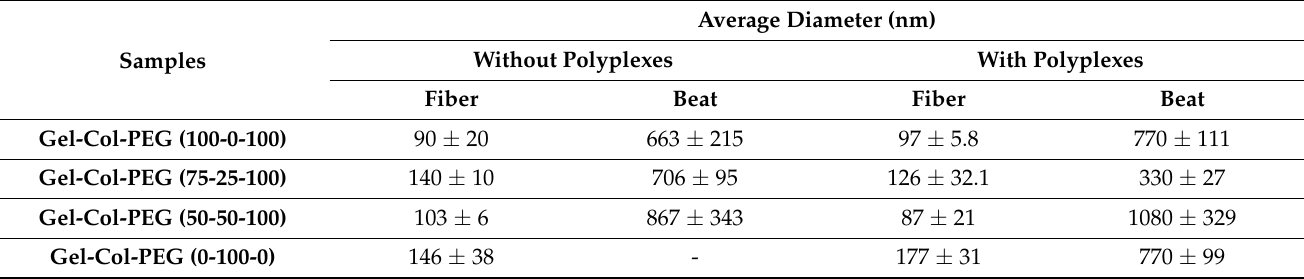
Figure 1. SEM images of different volume ratio Gelatin-Collagen-PEG electrospun fibers without and with complexes; Gelatine-Collagen-PEG (100-0-100) fiber mat without ( A ) and with pDNA complexes ( B ); Gelatine-Collagen-PEG (75-25- 100) fiber mat without ( C ) and with pDNA complexes ( D ); Gelatine-Collagen-PEG (50-0-50) fiber mat without ( E ) and with pDNA complexes ( F ); Gelatine-Collagen-PEG (0-100-0) fiber mat without ( G ) and with pDNA complexes ( H ) (scale bars 10 and 1 μm). Red arrows show some beads along the nanofibers (blue arrows).